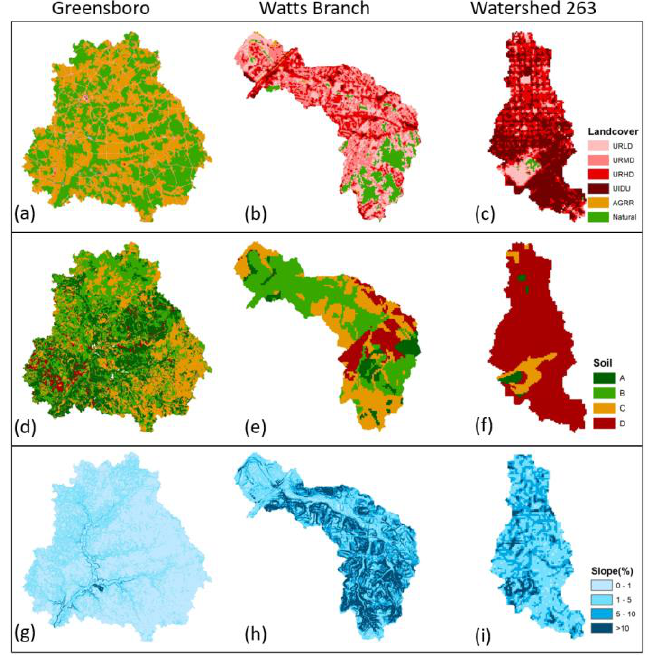
Figure 2. ( a, b, c ) Land cover, ( d, e, f ) soil, and ( g, h, i ) slopes of the study watersheds (Greensboro, Watts Branch, and Watershed 263).